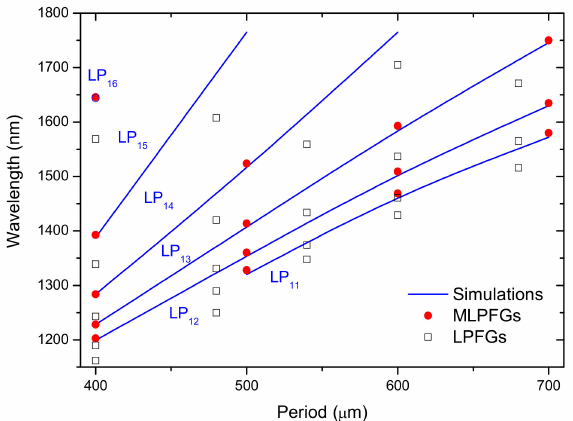
Figure 18. Dispersion curves corresponding to arc- and mechanically-induced gratings in the SMF28 fiber (simulations apply to MLPFGs). Reprinted with permission from ref. [131]. © 2008 Wiley Periodicals,